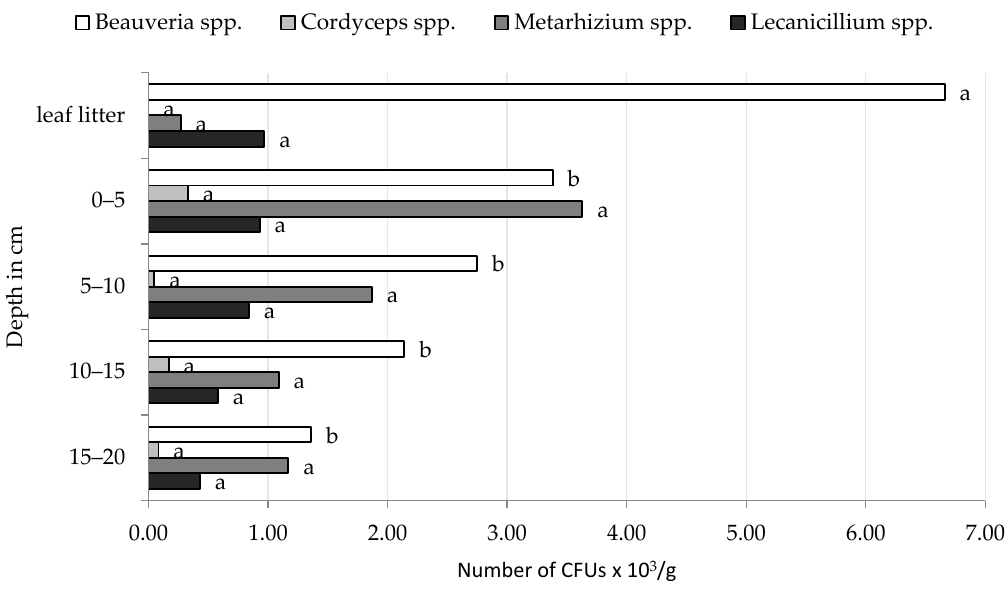
Figure 1. Average density of CFUs of entomopathogenic fungi in the leaf litter and individual layers of forest soils collected in Golice. ab Statistically significant differences between the concentration of CFUs of entomopathogenic fungi depending on the soil depth.